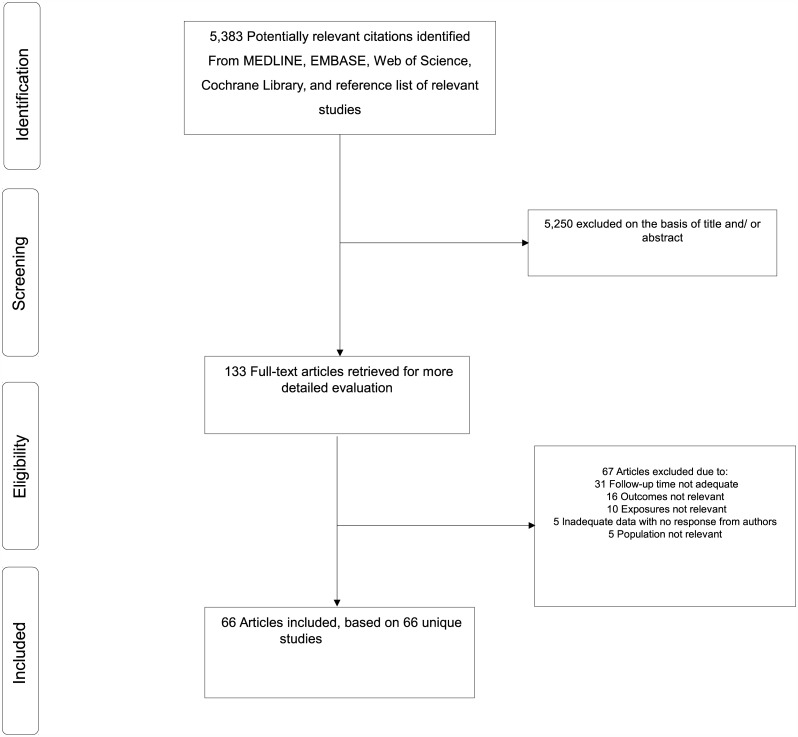
PRISMA flow diagram.